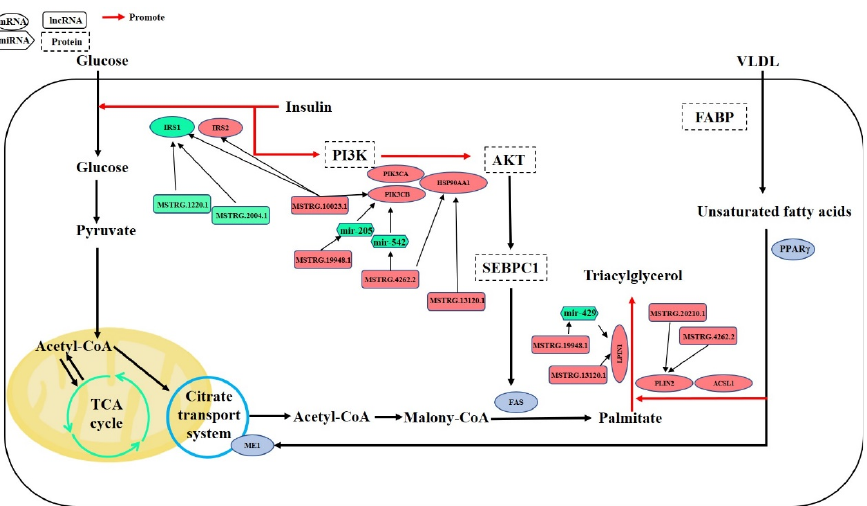
Figure 6. The major potential differentially expressed target genes (DEPTGs) and differentially expressed genes (DEGs) with lipid deposition in related pathways. Red indicates high expression in longissimus dorsi muscle (LD) of Songliao black (SL) pigs, and green indicates low expression.